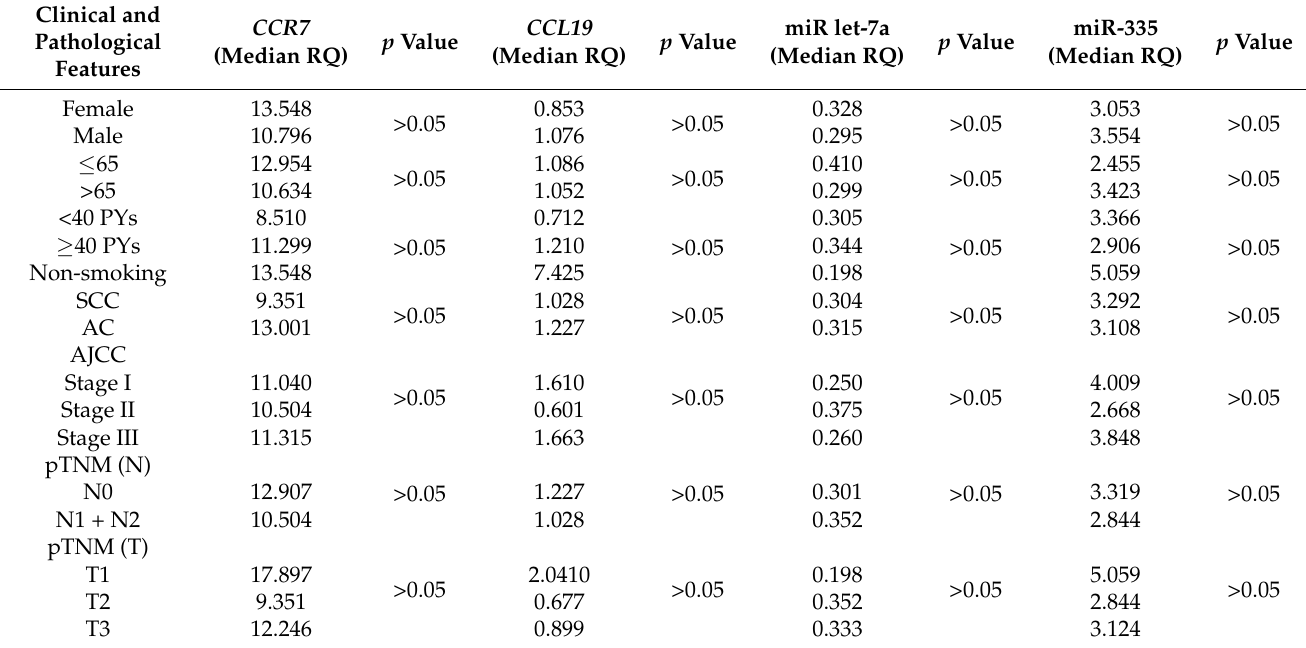
Table 2. Clinical and pathological features: median expression level (RQ value) of evaluated genes and miRNAs in tumor tissue